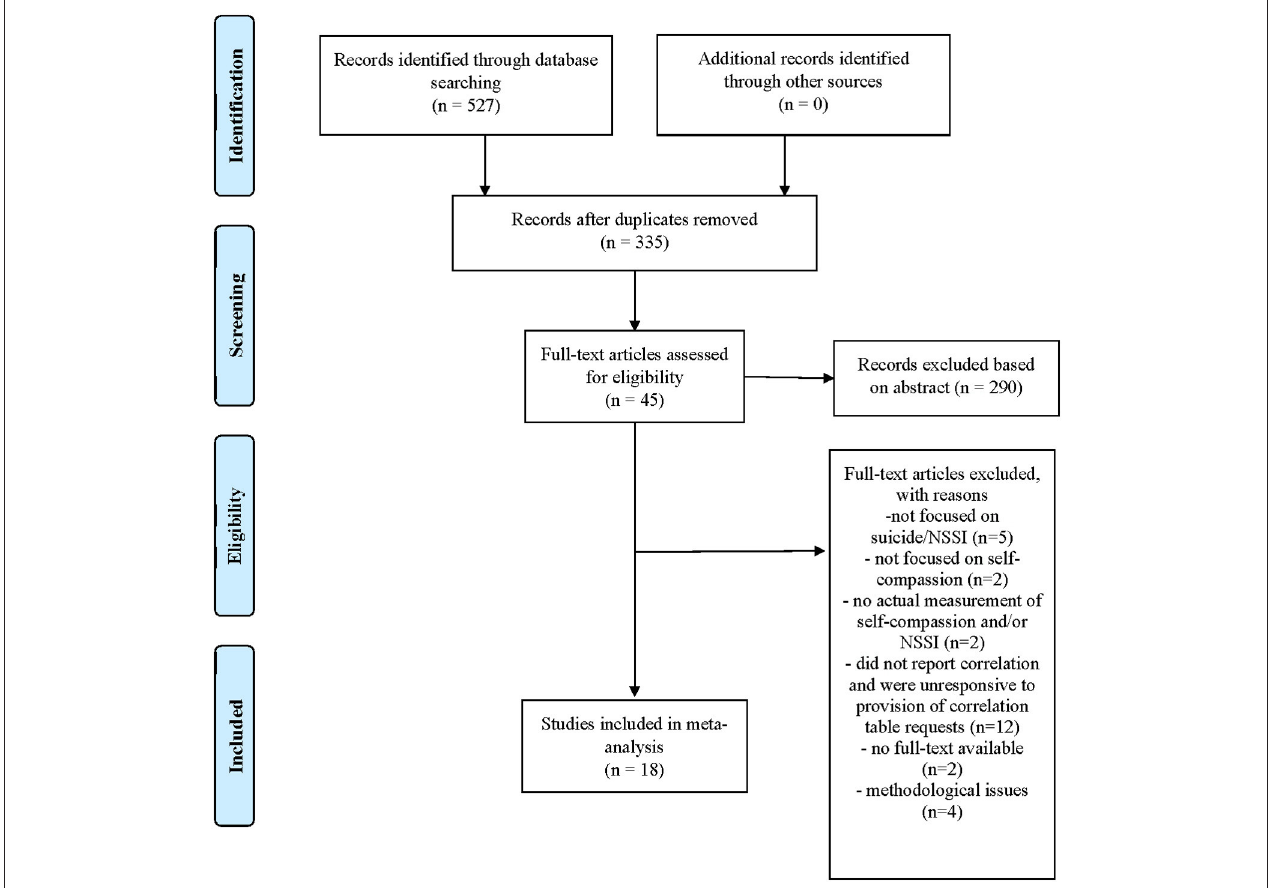
FIGURE 1 | Flow diagram of the study